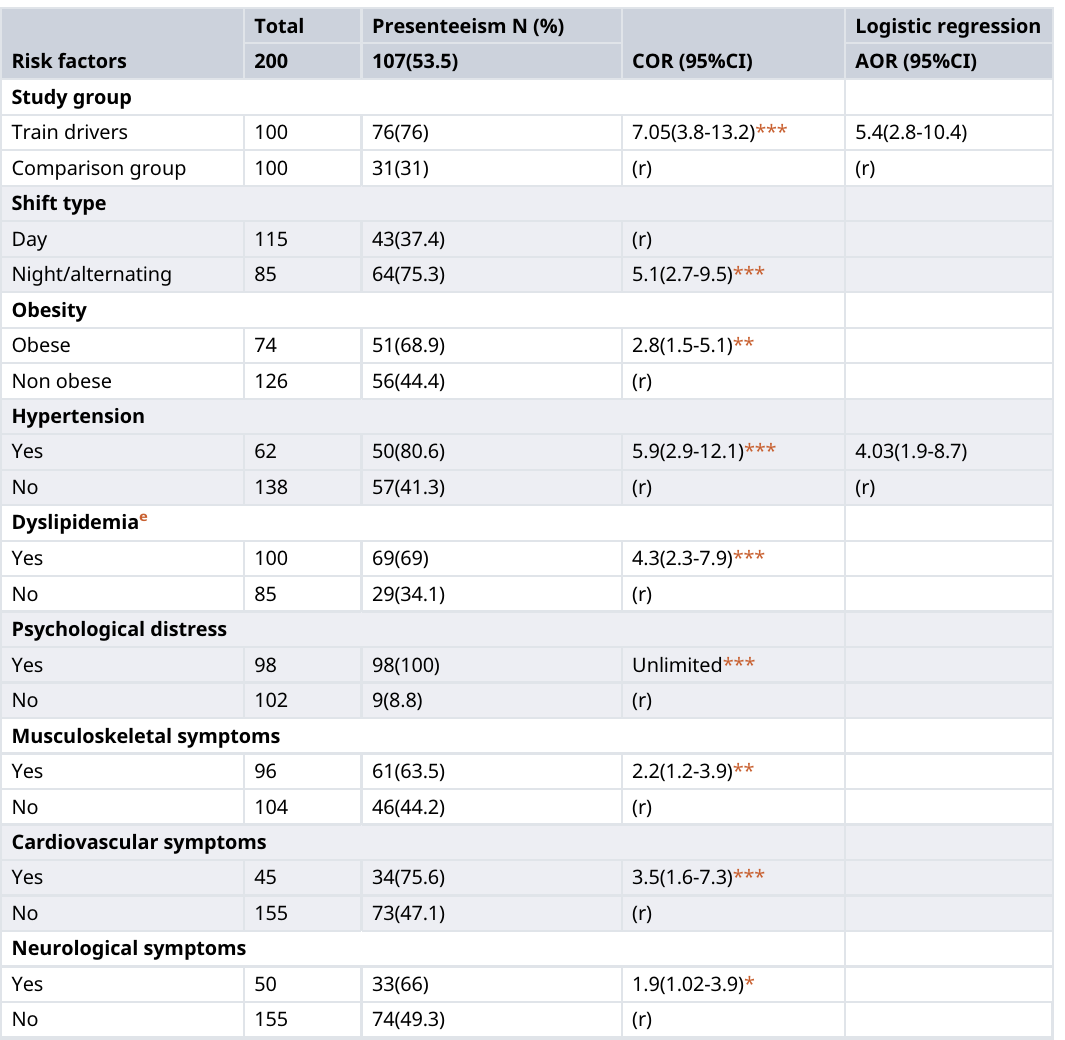
Table 5. Logistic regression analysis of independent predictors of presenteeism among study